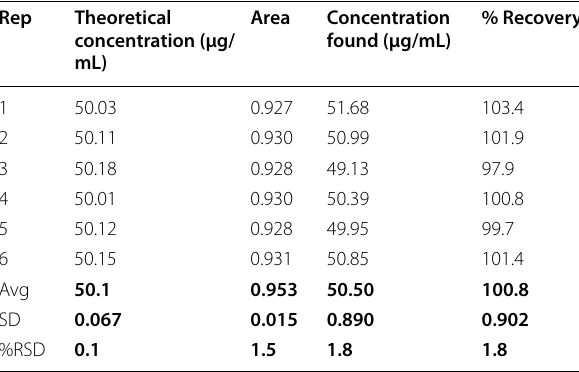
Table 5 Method precision results